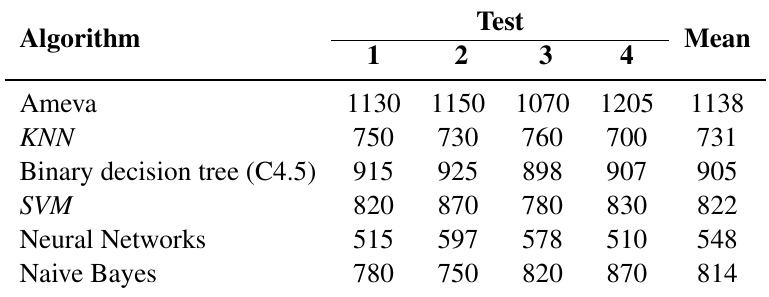
Table 8. Battery lifetime in minutes for the execution with different classifiers.